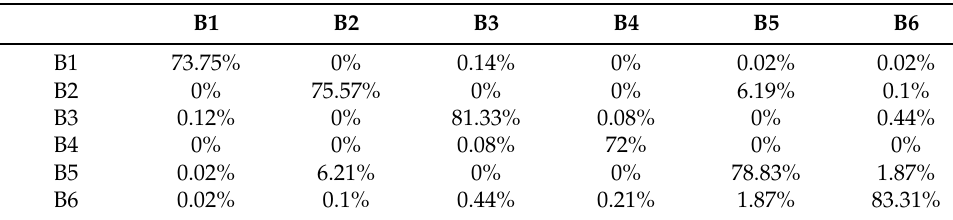
Table 2. Compatibility ratio for the Xilinx Spartan 6 x 4 + x 3 + 1.